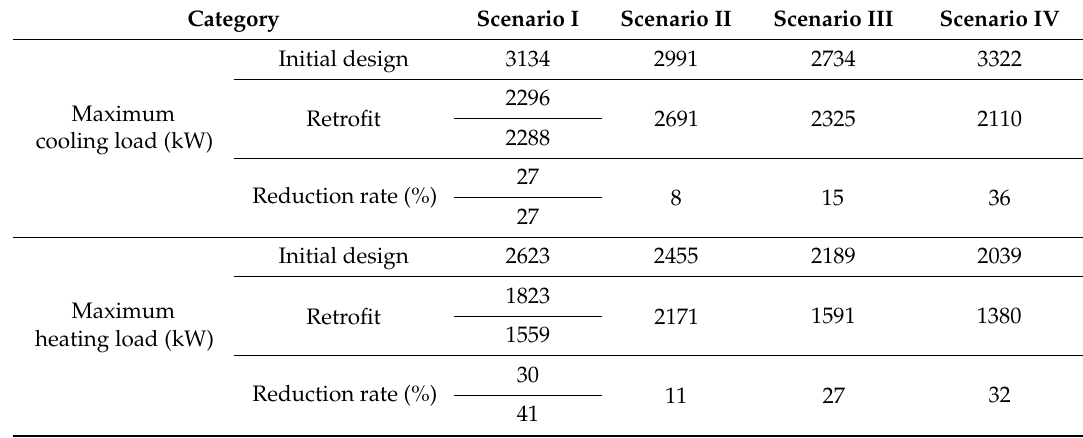
Table 12. The results of calculating the maximum cooling and heating load for the entire